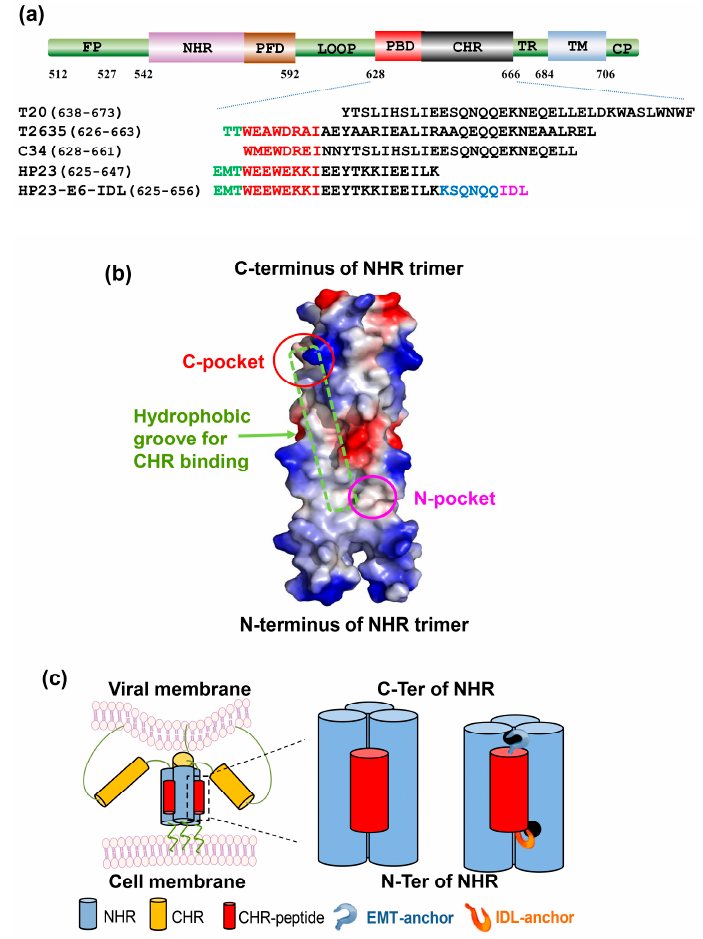
Figure 1. Design strategy for HP23-E6-IDL. ( a ) Domain distribution of HIV-1 gp41 and sequences of peptides. CP, cytoplasm region; TM, transmembrane region; TR, tryptophan-rich region; CHR, C-terminal heptad repeat; PBD, pocket-binding domain; PFD, pocket-forming domain; NHR, N-terminal heptad repeat; FP, fusion peptide region; ( b ) Crystal structure of gp41 NHR trimer (PDB 2X7R) is shown as an electrostatic surface. Red and pink circles indicate the NHR C-terminal deep hydrophobic pocket and N-terminal shallow pocket, respectively. Green box indicates the hydrophobic groove for CHR binding; ( c ) Schematic diagram showing the design concept of HP23-E6-IDL. HP23-E6-IDL with both